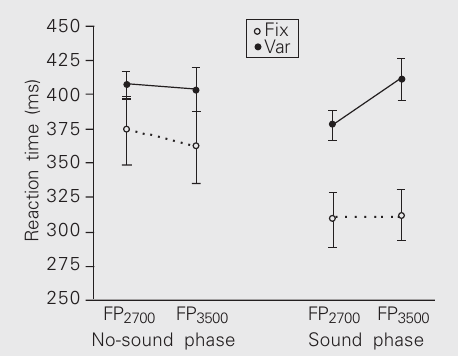
Figure 2. Reaction times of group fix (G Fix ) and group var (G Var ) in the no-sound and sound phases of the second testing session of Experiment 1b. For G Fix the accessory stimulus always preceded the target stimulus by 200 ms. For G Var the accessory stimulus sometimes preceded the target stimulus by 200 ms and some- times preceded it by 1000 ms. FP 2700 and FP 3500 refer to the interval between the appear- ance of the fixation point and the appearance of the target stimulus. Data are reported as means ± SEM for 6 volunteers in each